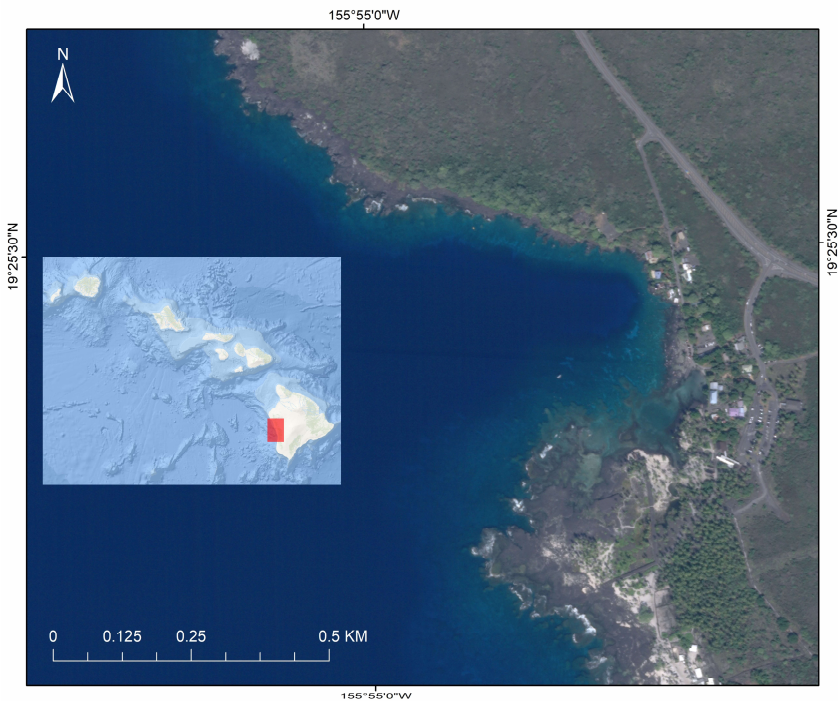
Figure A1. SkySat satellite image of study site in Honaunau Bay, Hawai’i Island.